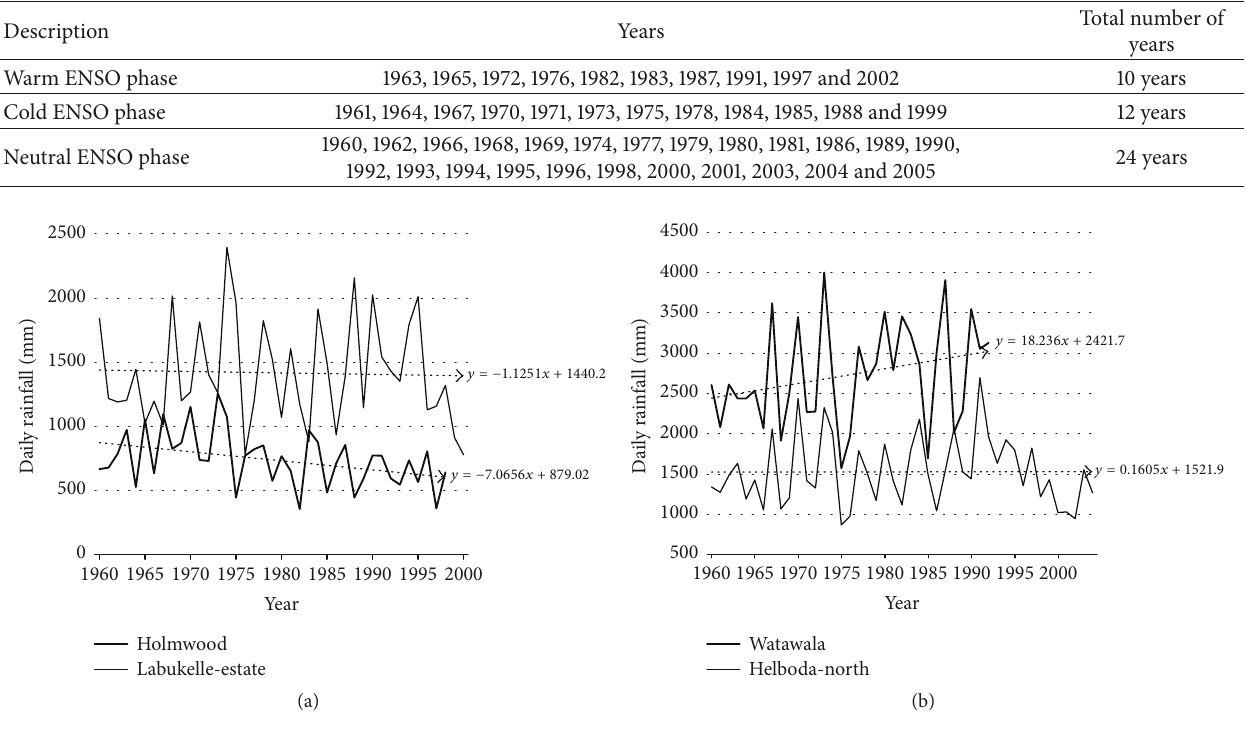
Figure 3: Holmwood and Labukelle–estate stations show decreasing rainfall trends (a) and Watawala and Helboda–north stations show increasing rainfall trends (b).